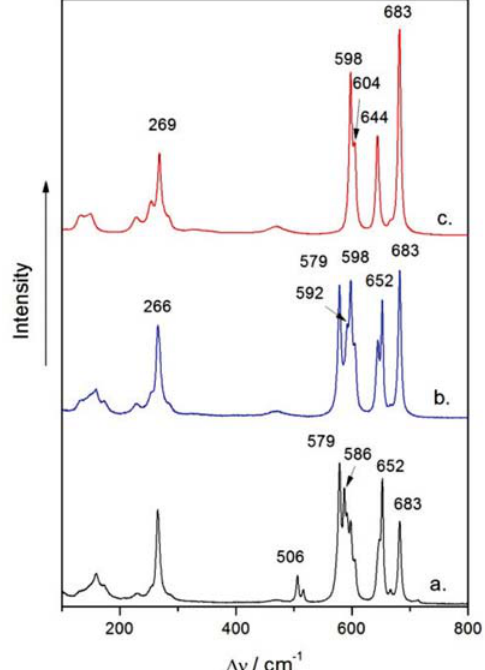
Figure 2 : Raman spectra of the reaction mixture during the isola- tion of ruthenium compound on the vacuum system: a.) mixture